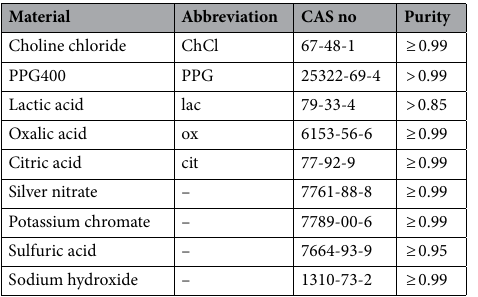
Table 1. All data corresponding to used materials in this